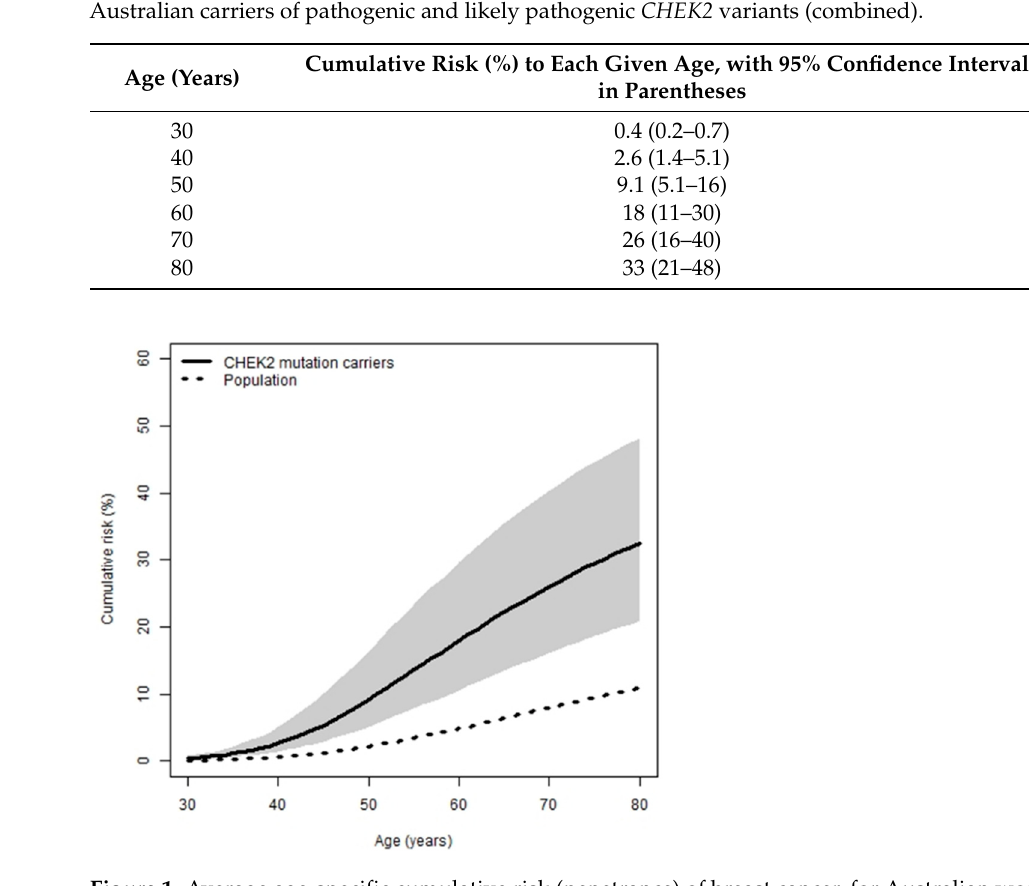
Figure 1. Average age-specific cumulative risk (penetrance) of breast cancer, for Australian women (dashed line) and for female carriers of pathogenic and likely pathogenic CHEK2 variants combined (solid line), with confidence intervals for carriers (grey region).